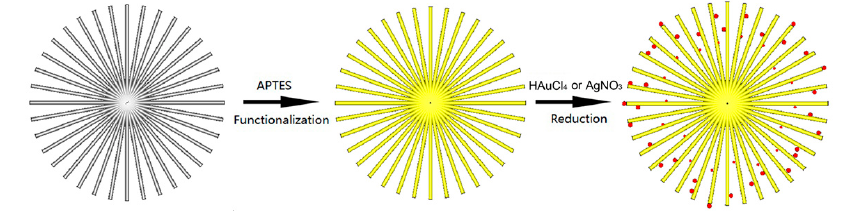
Figure 11. Schematic illustration of the synthesis process of urchin-like TiO 2 decorated with Au or Ag nanoparticles [31].